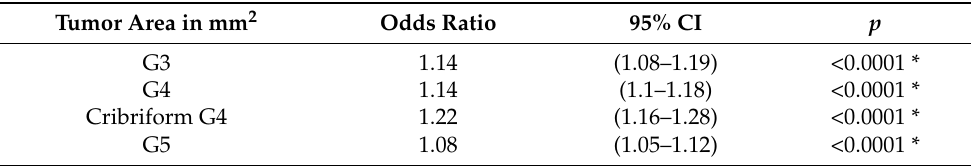
every AI-determined-class-dependent tumor area attributes to the AI-assessed GG in a similar way as the pathologist.